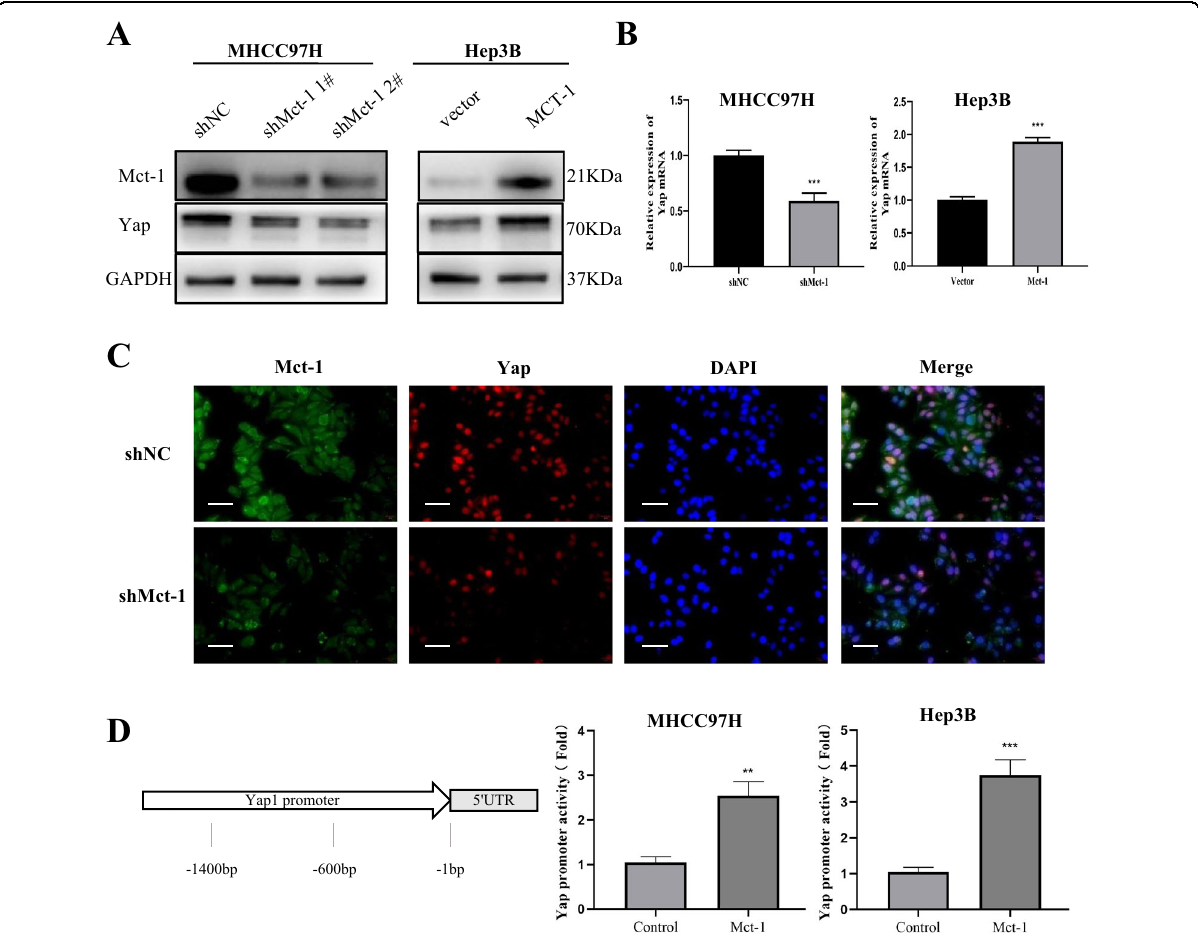
Fig. 6 Mct-1 increases Yap expression through its transcription factor activity. Yap expression was assessed by western blot ( A ) and qRT-PCR ( B ) analyses. C Immuno fl uorescent staining images of Mct-1 and Yap in MHCC97H-NC and MHCC-97H-shMct-1. Scale bar = 50 µm. D Primers speci fi c for the Yap promoter region ( − 1400 to − 1) were designed for the dual-luciferase reporter assay. The luciferase activity of the pGL3-Yap-Luc vector was enhanced in MHCC97H and Hep3B cells after transfection with the Mct-1 plasmid. The data are presented as the mean ± SD of experiments performed in triplicate. * p < 0.05, ** p < 0.01, *** p <